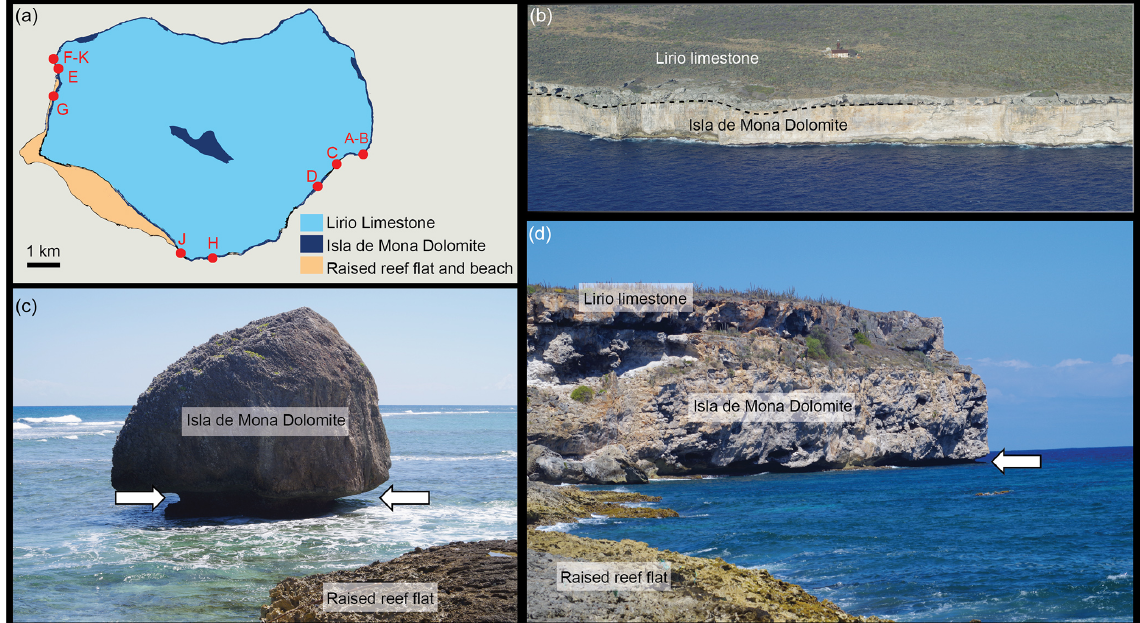
Figure 1. Isla de Mona setting: (a) simplified geological map modified from that of Briggs and Seiders (1972), showing the locations of the sampling sites. (b) Sky view of Isla de Mona: the cliff is composed of the Isla de Mona Dolomite topped by the Lirio limestone and the Isla de Mona lighthouse is visible. ( c – d ) Views of Isla de Mona coastal area: samples were taken from isolated boulders (c) and directly from the cliff (d) , at the notch (white arrows c – d ) or on the raised reef flat ( c – d